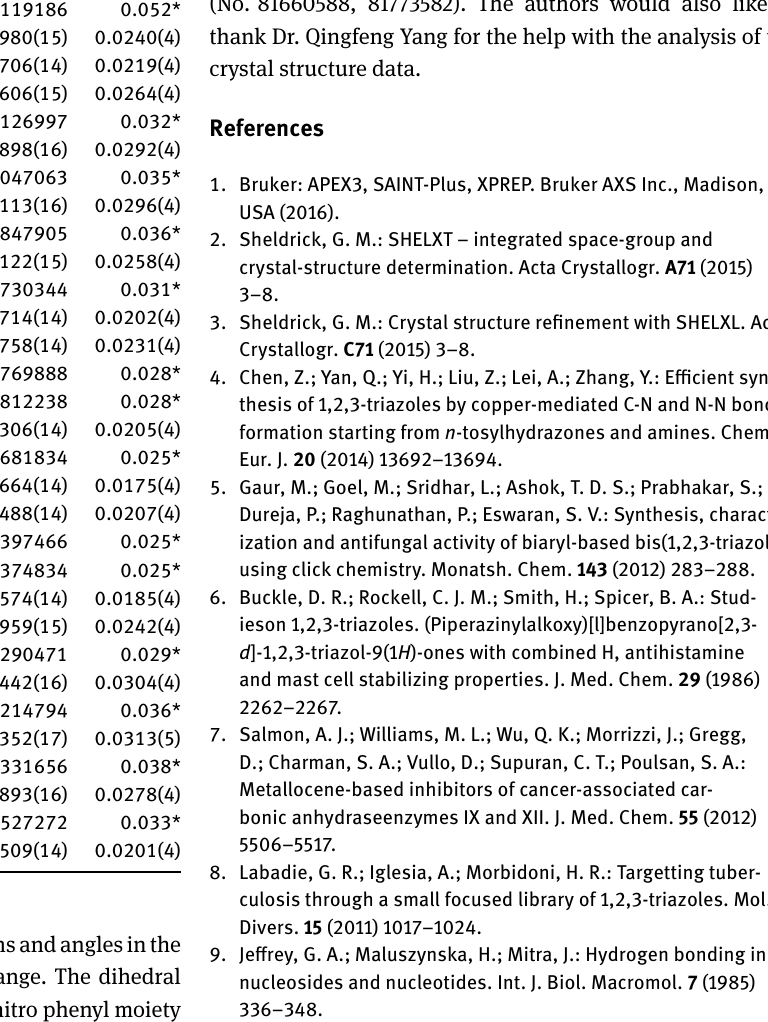
inthetitlecrystalstructure.Allbondlengthsandanglesinthe crystal structure are within the normal range. The dihedral angle between the triazole ring and the 2-nitro phenyl